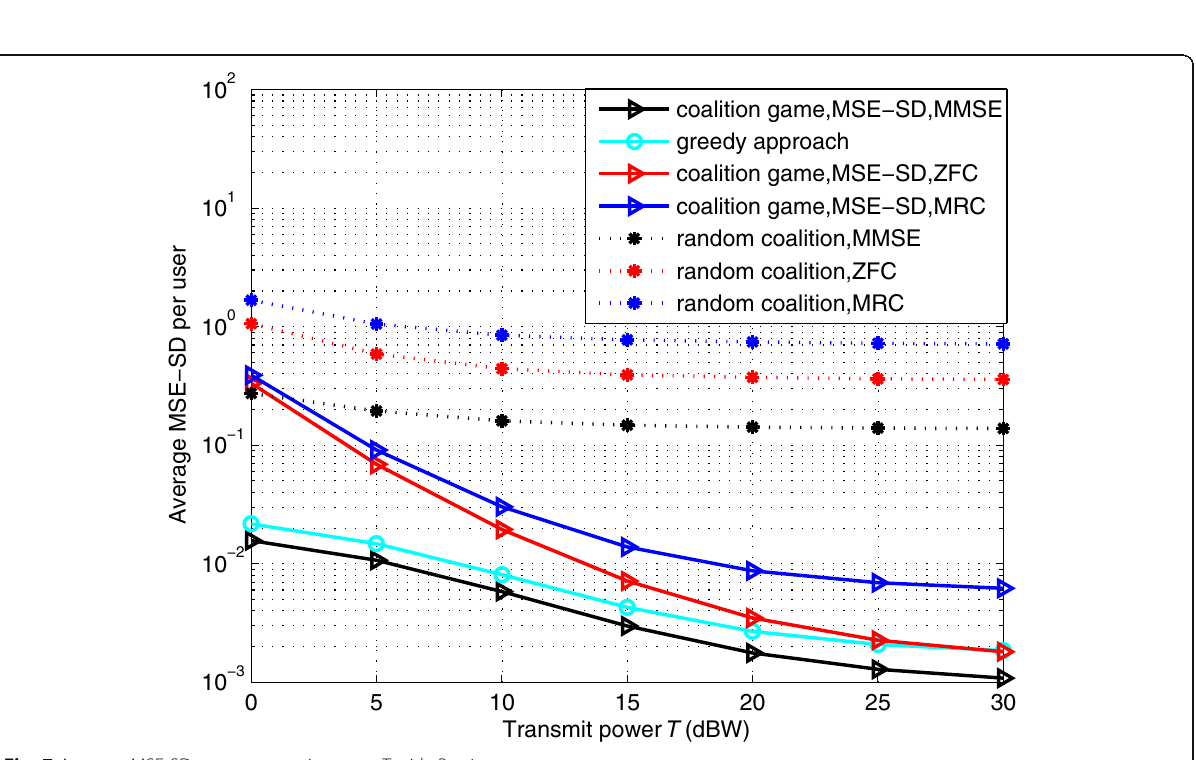
Fig. 7 Average MSE-SD versus transmit power T with P =